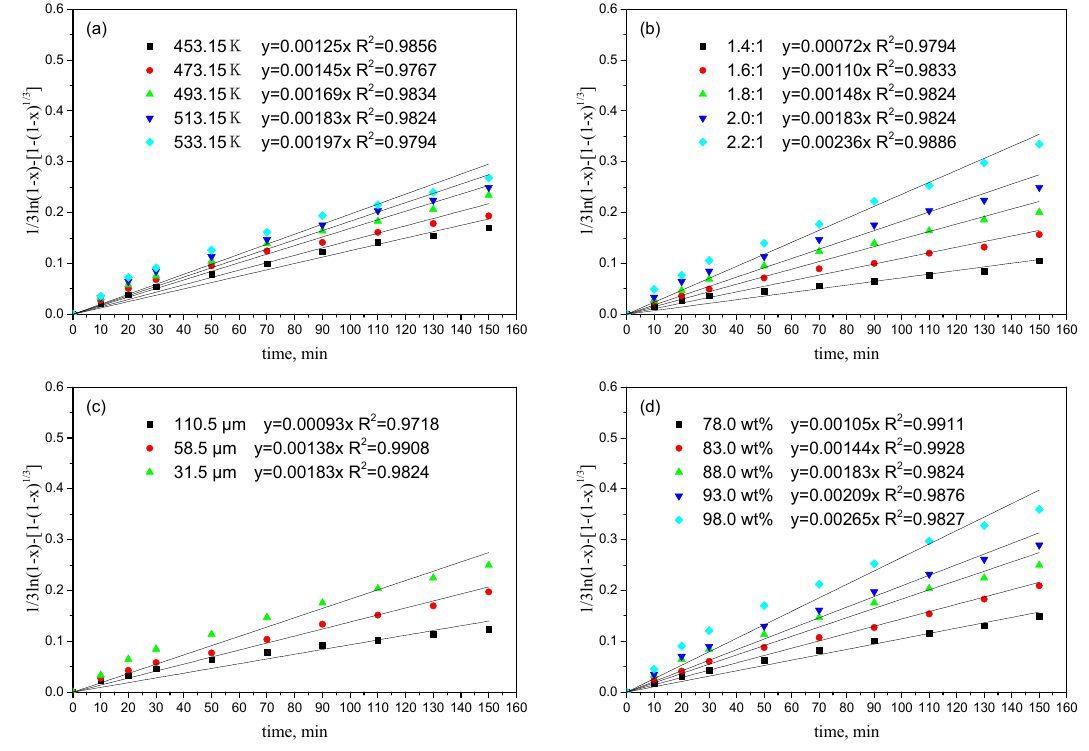
1 Figure 8. Plot of 1 ln ( 1 − X ) − [ 1 − ( 1 − X ) 3 ] versus time with variations in di ff erent parameters: ln(1 - X) - [1 - (1 - X) (cid:2869) (cid:2871)⁄ ] versus time with variations in different parameters: ( a ) Figure 8. Plot of (cid:2869) 3 (cid:2871) ( a ) temperature; ( b ) acid / solid weight ratio; ( c ) particle size; ( d ) initial sulfuric acid temperature; ( b ) acid/solid weight ratio; ( c ) particle size; ( d ) initial sulfuric acid concentration.